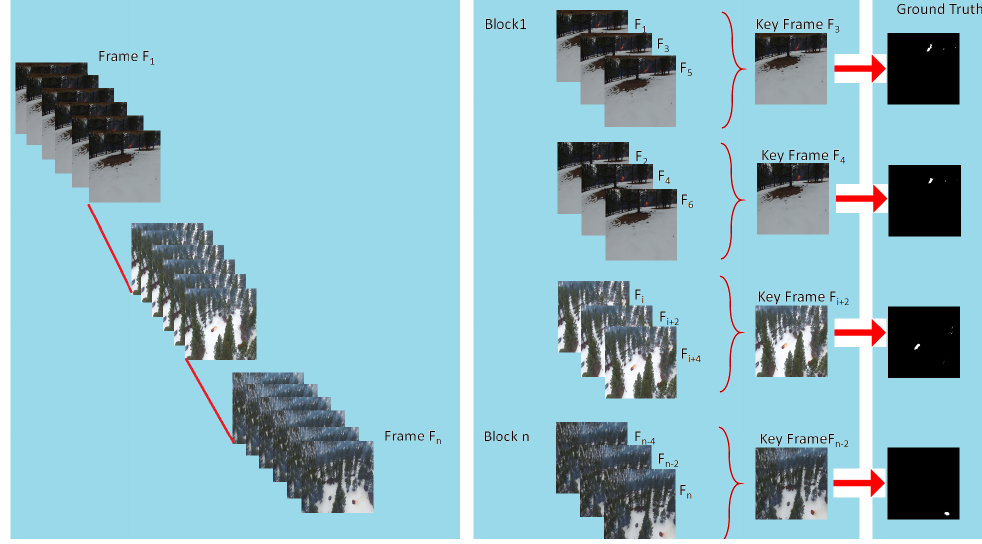
Figure 6. Example of training